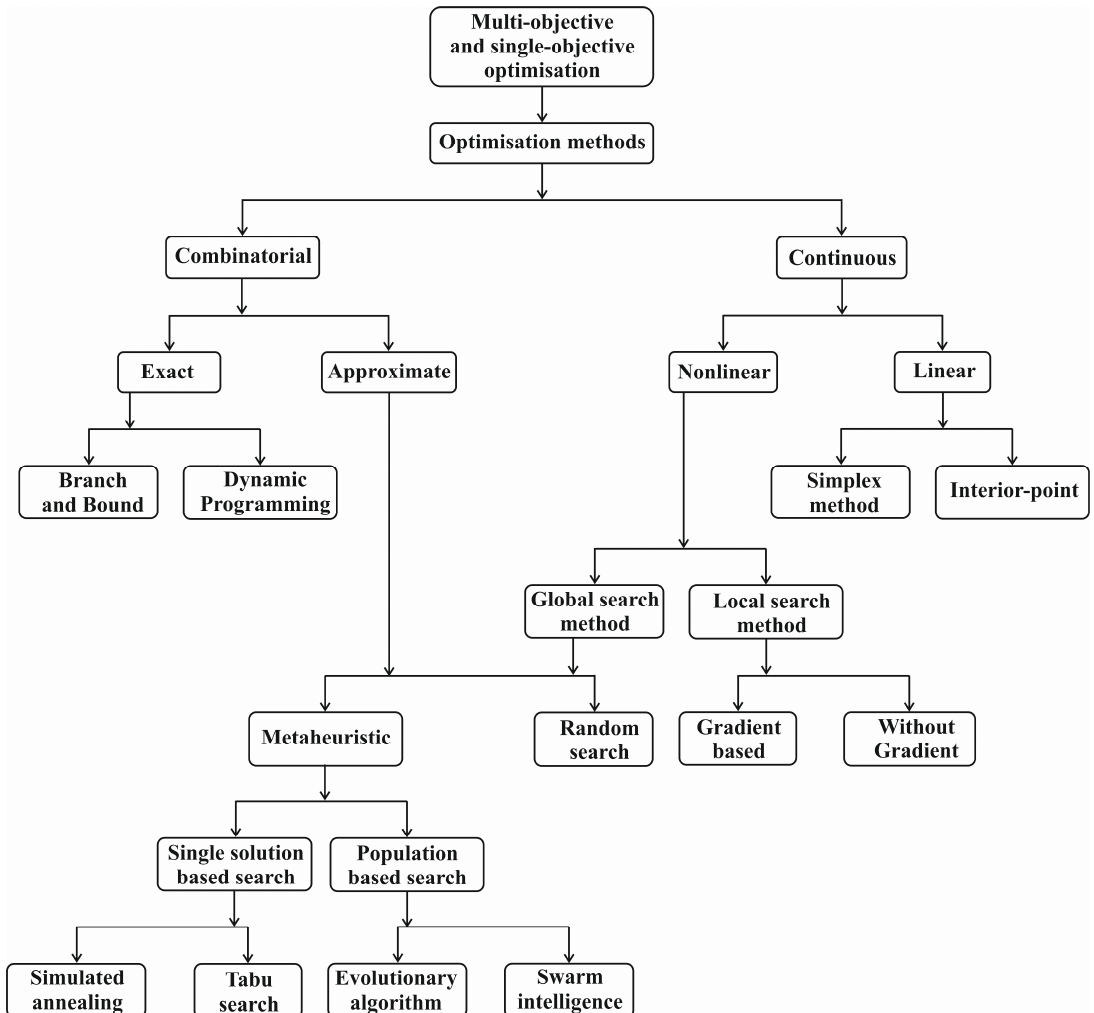
Figure 1. Division of optimisation methods that can be used to solve problems related to the power industry acc to [115–119]. Table 1. Selected classical optimisation methods with algorithms [116].